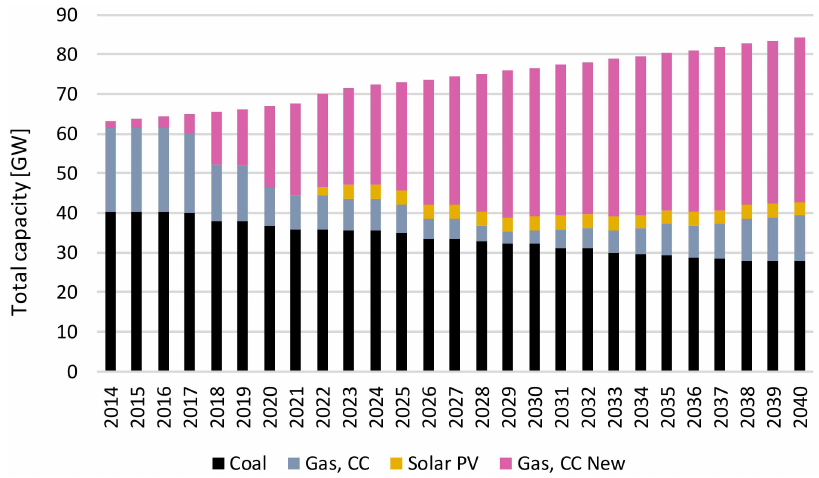
Figure 15. Total capacity (GW) in the REF scenario, in cases of decreasing cost of retrofit—with code modifications.